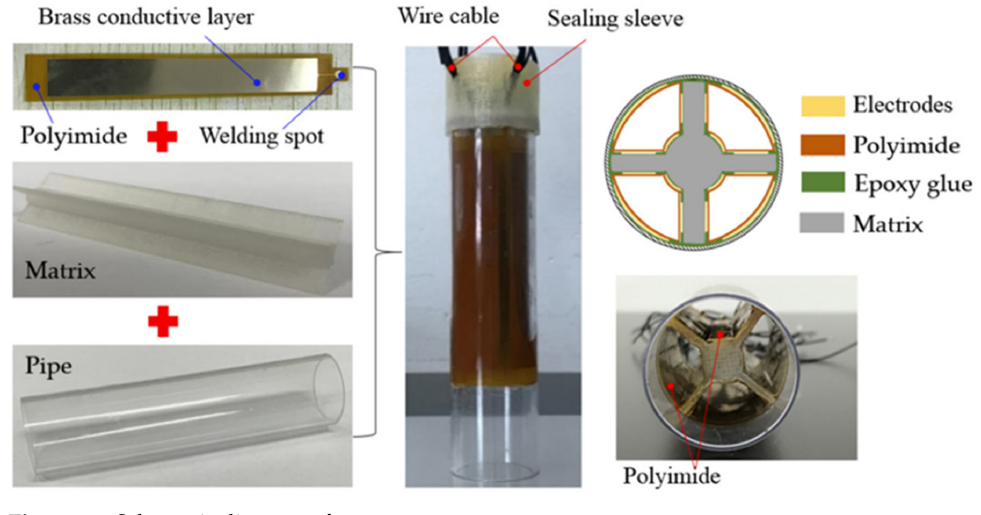
Figure 14. Schematic diagram of sensor.